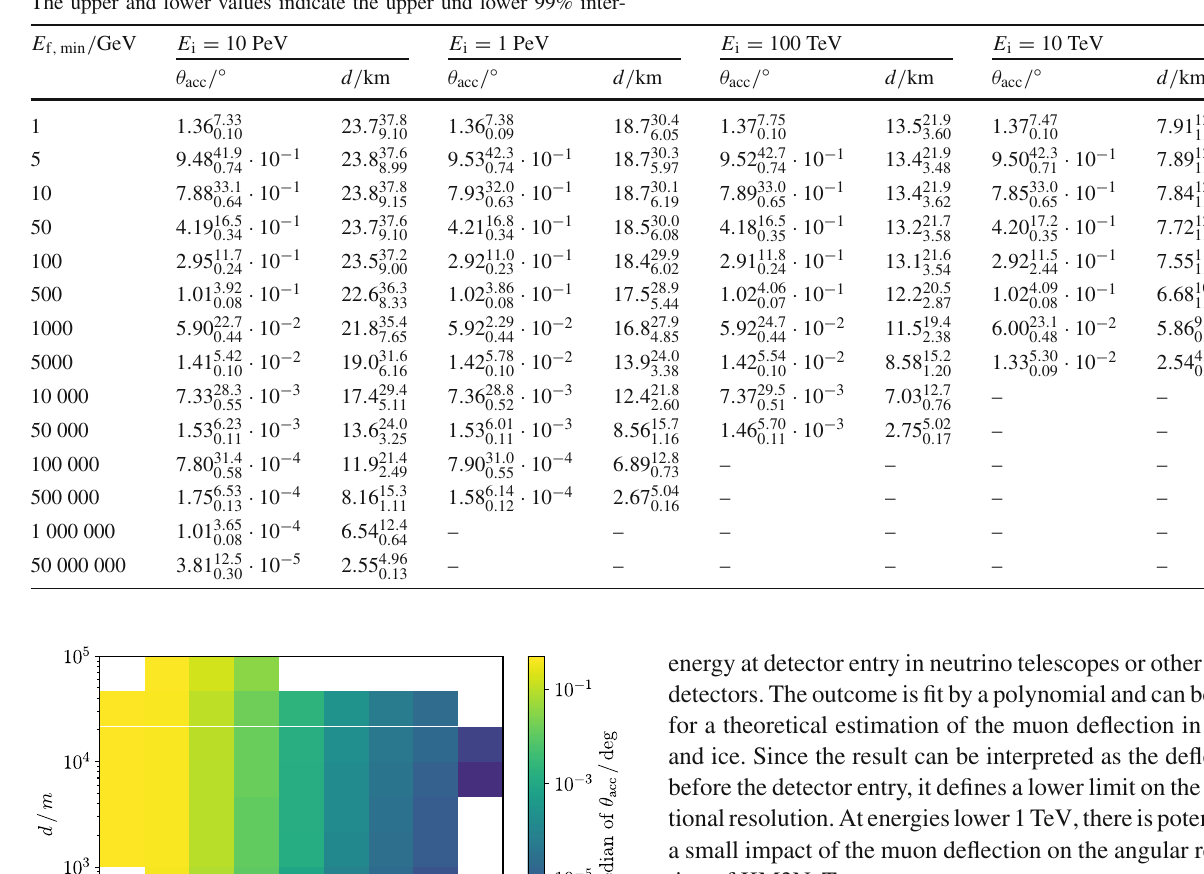
vals around the median. It turns out that the median deflection depends primarily only on the final muon energy E f , min